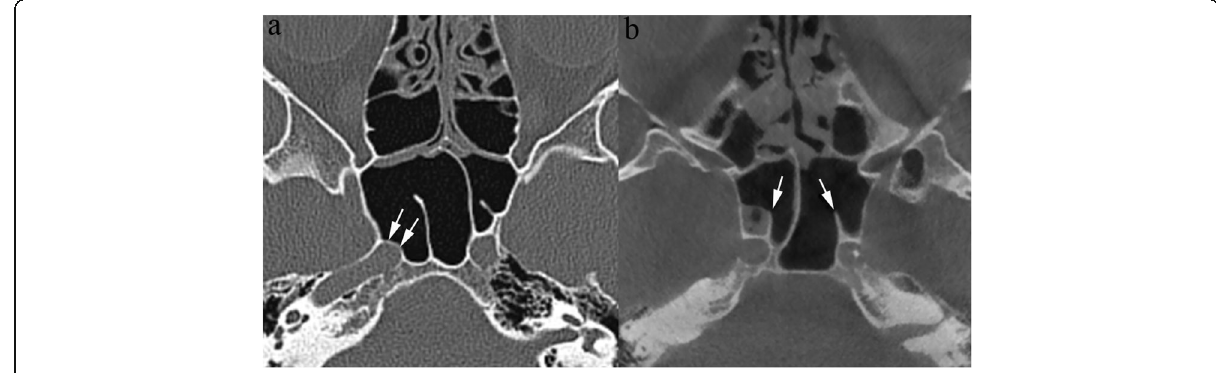
Fig. 6 Carotid canal variants. a Both canals protrude into the sphenoid sinus cavities; the bony wall is thinned on the right side (arrows). b Incomplete bony septa stem from the bony walls of the canals (arrows): during endoscopic surgery, such septa may act as a leverage and facilitate injury of the ICA